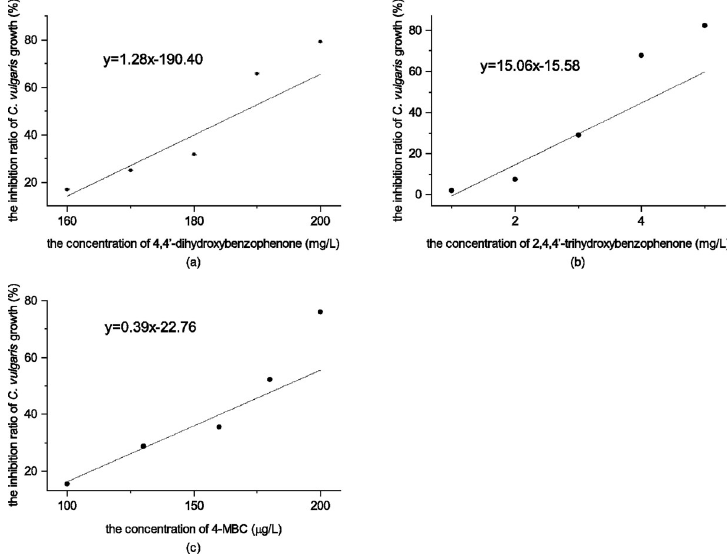
Fig 2. (a) The inhibition ratio of C . vulgaris growth of 4,4’-dihydroxybenzophenone; (b) The inhibition ratio of C . vulgaris growth of 2,4,4’-trihydroxybenzophenone; (c) The inhibition ratio of C . vulgaris growth of 4-MBC.